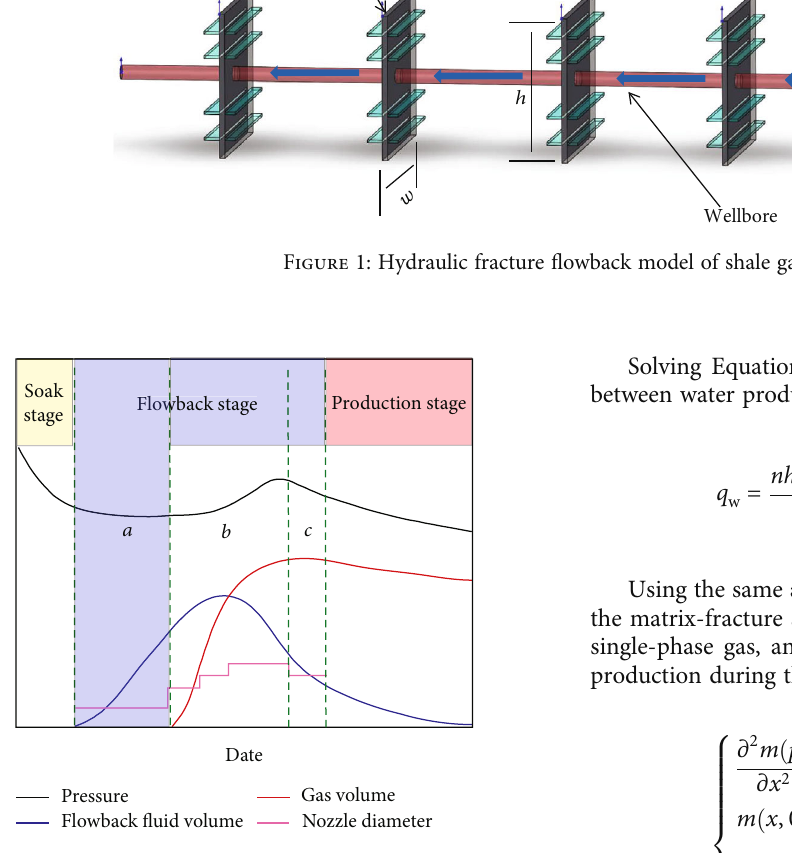
Figure 2: Flowback and production characteristic curves of shale gas well.